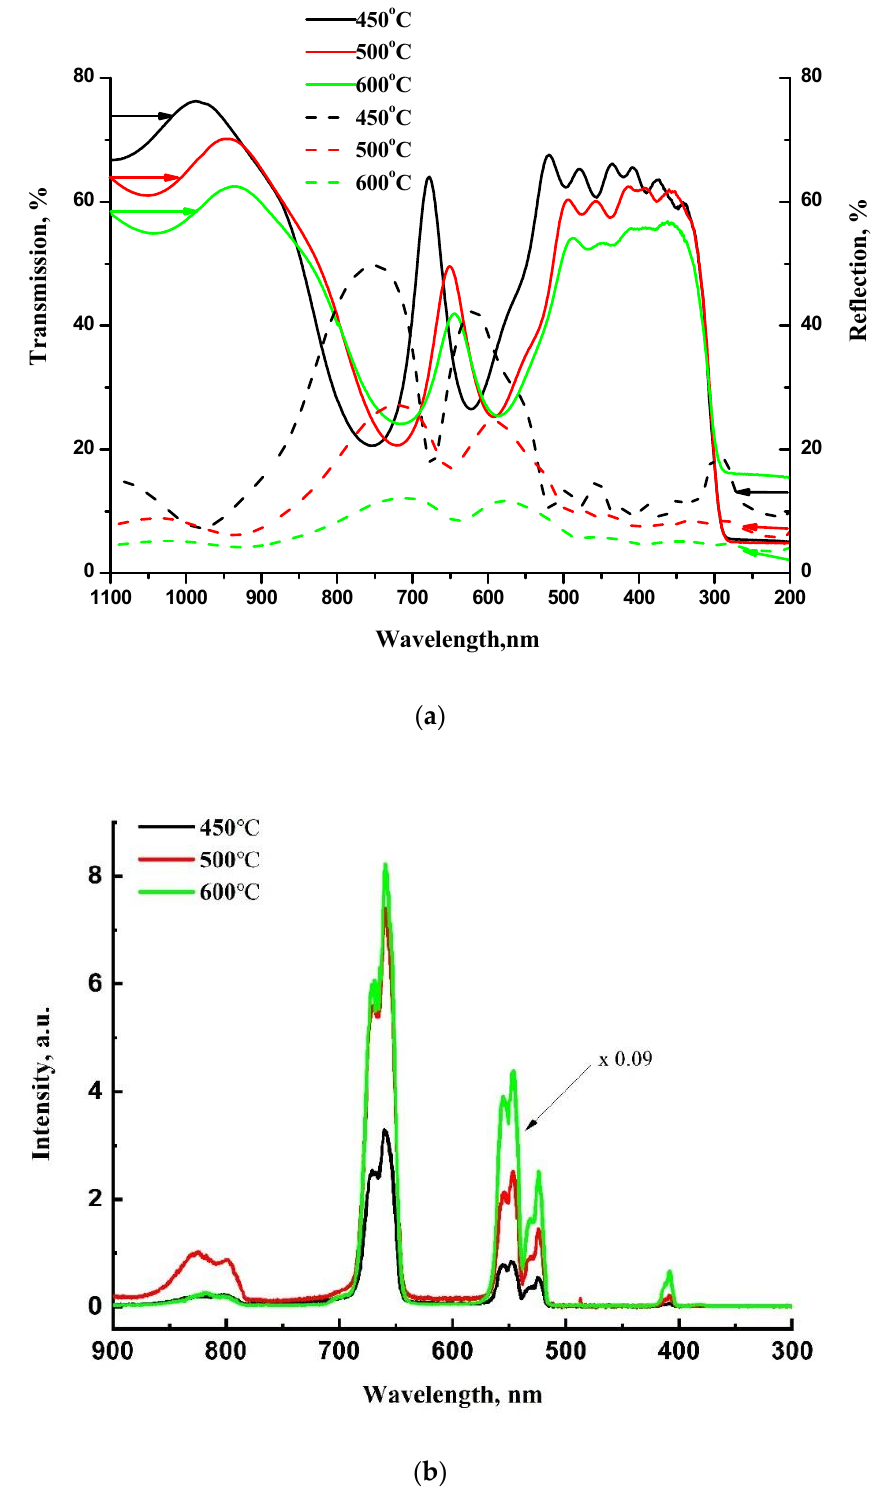
Figure 8. Room-temperature optical spectra of BaTiO 3 :(Er,Yb)/SiO 2 microcavity (sample F): ( a ) transmission (solid lines) and reflection (dashed lines) spectra of BaTiO 3 /SiO 2 microcavity on a fused silica after final annealing at 450 °C (black lines), 500 °C (red lines) and 600 °C (green lines); ( b ) upconversion PL spectra of the microcavity obtained after final annealing at 450 °C (black line), 500 °C (red line) and 600 °C (green line). Each barium titanate layer is doped with Er and Yb.